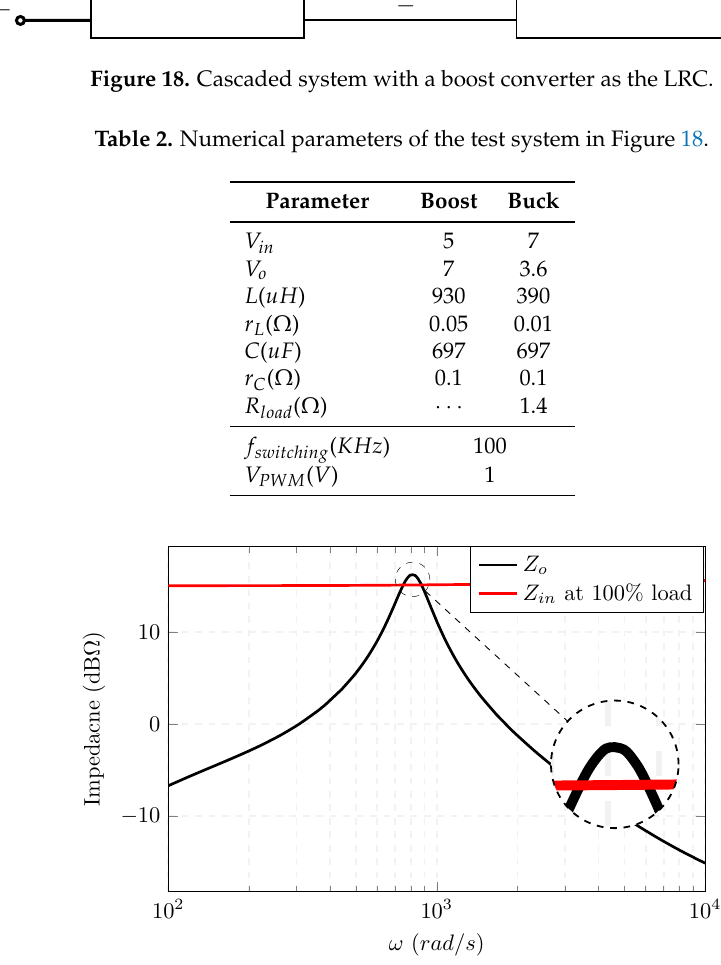
Figure 19. Impedance interaction between the boost and the buck